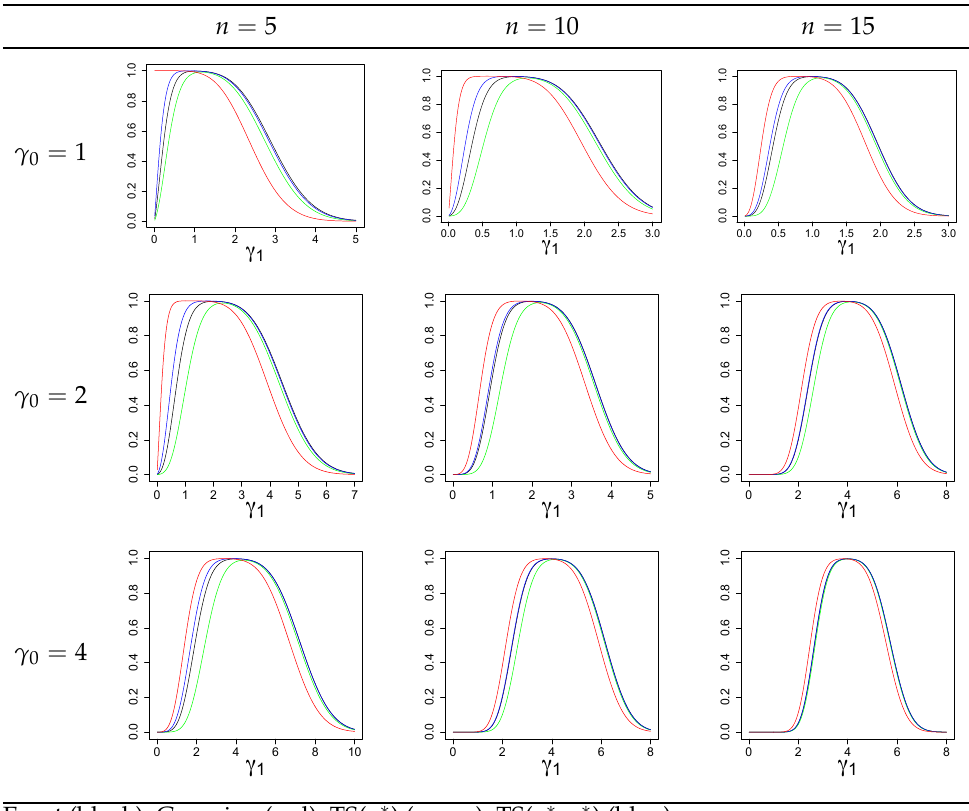
Figure 4. Operating characteristic (OC) curves of an ¯ X chart with subgroups of size n for a = 3 ) population distribution with shifted shape parameter γ = γ Gamma ( γ , 1 λ is the in-control